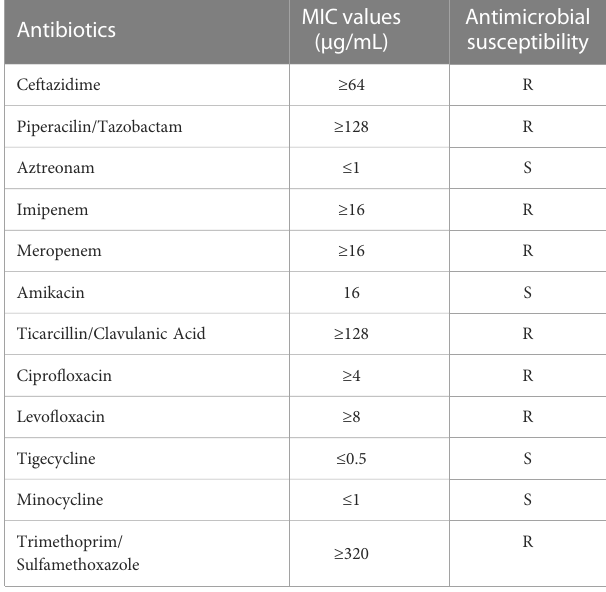
TABLE 1 Antimicrobial susceptibility pro fi les of A. caviae 211703. Antibiotics